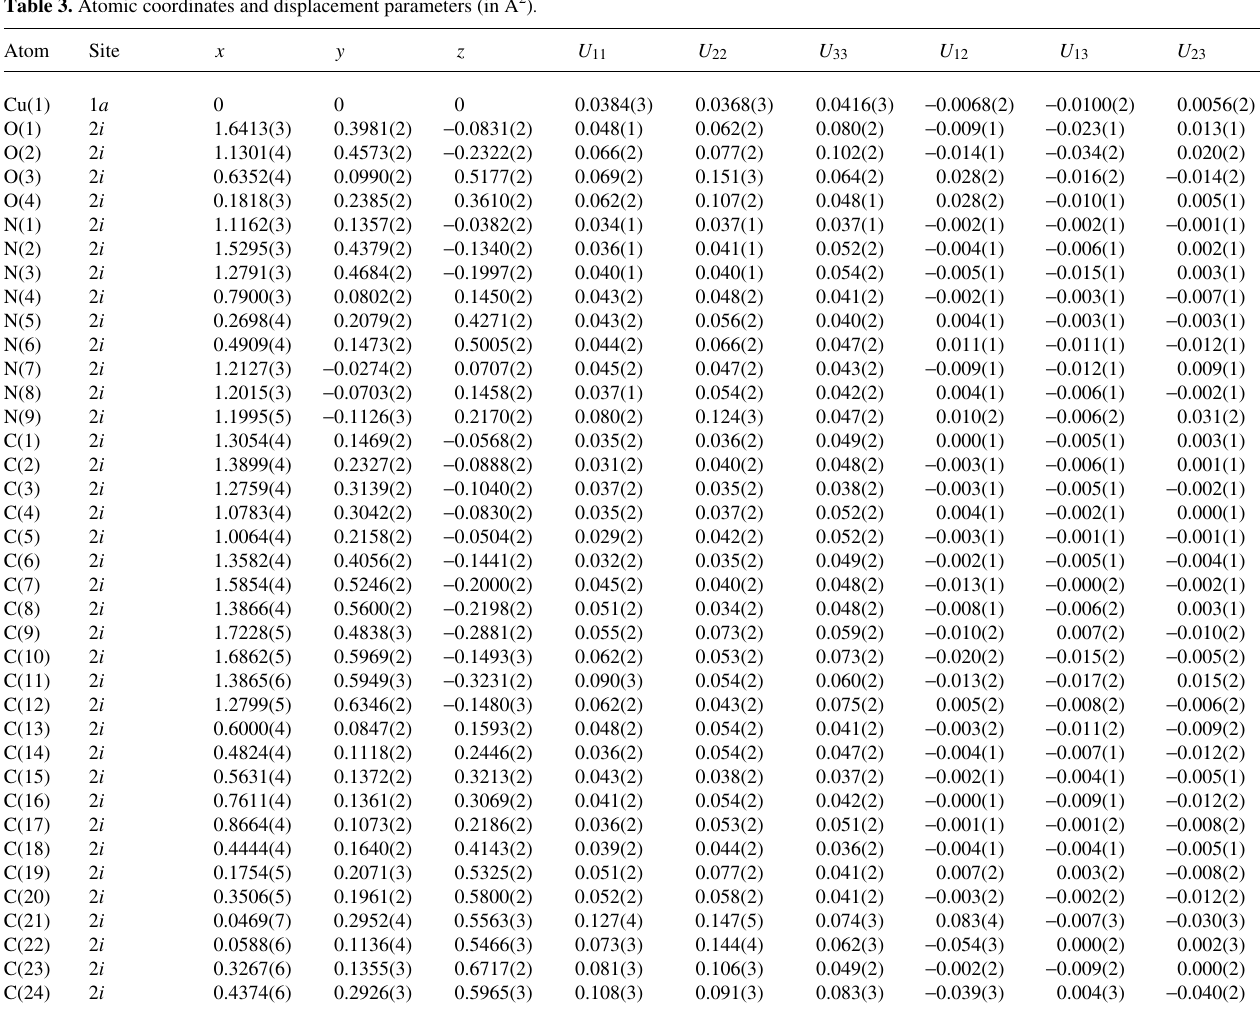
Table 3. Atomic coordinates and displacement parameters (in Å 2 )